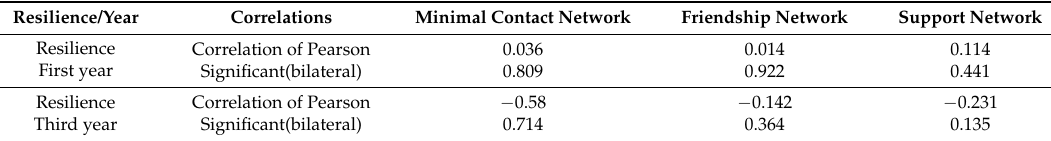
Table 4. Correlations between resilience and ego density in the support and friendship networks in the first and third